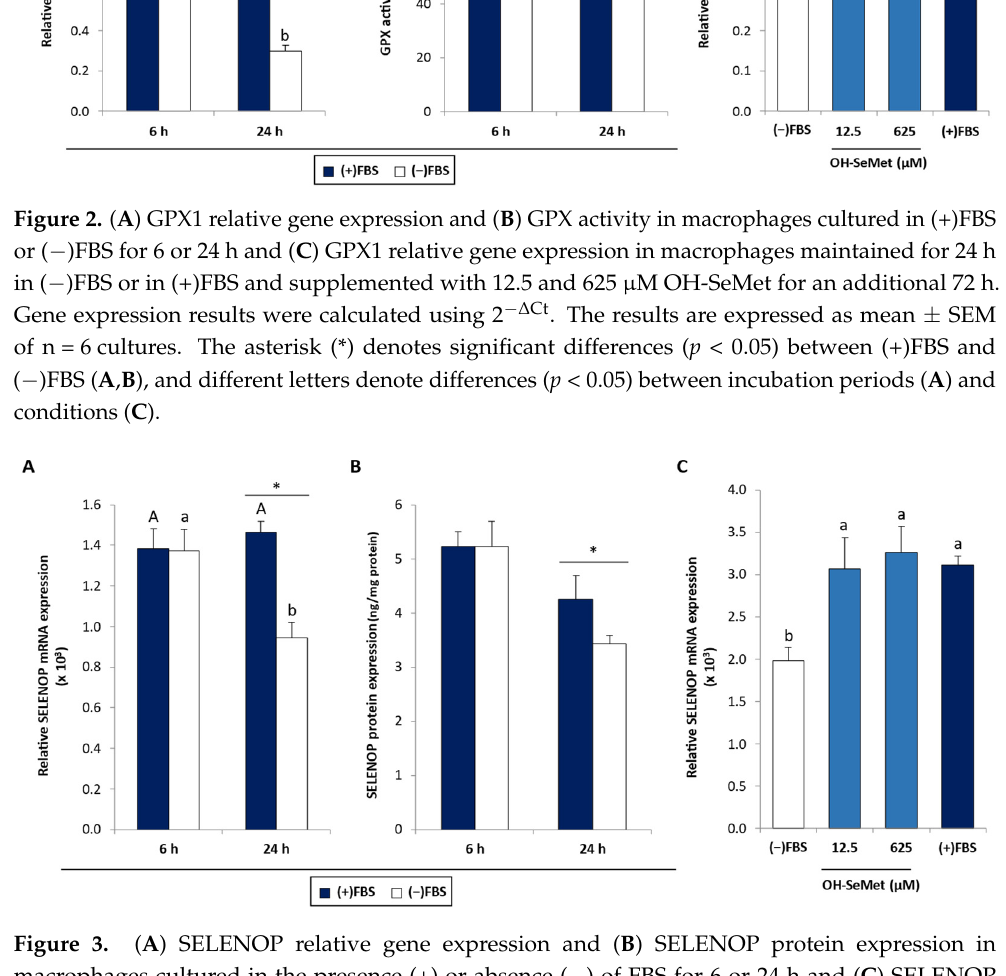
Figure 3. ( A ) SELENOP relative gene expression and ( B ) SELENOP protein expression in macrophages cultured in the presence (+) or absence ( − ) of FBS for 6 or 24 h and ( C ) SELENOP relative gene expression in macrophages maintained for 24 h in (+)FBS or in ( − )FBS and supplemented with 12.5 and 625 μ M OH-SeMet for an additional 72 h. Gene expression results were calculated using 2 −Δ Ct . The results are expressed as mean ± SEM of n = 6 cultures. The asterisk (*) denotes significant differences ( p < 0.05) between (+)FBS and ( − )FBS ( A and B ) and the letters denote differences ( p < 0.05) between incubation periods ( A ) and conditions ( C ).